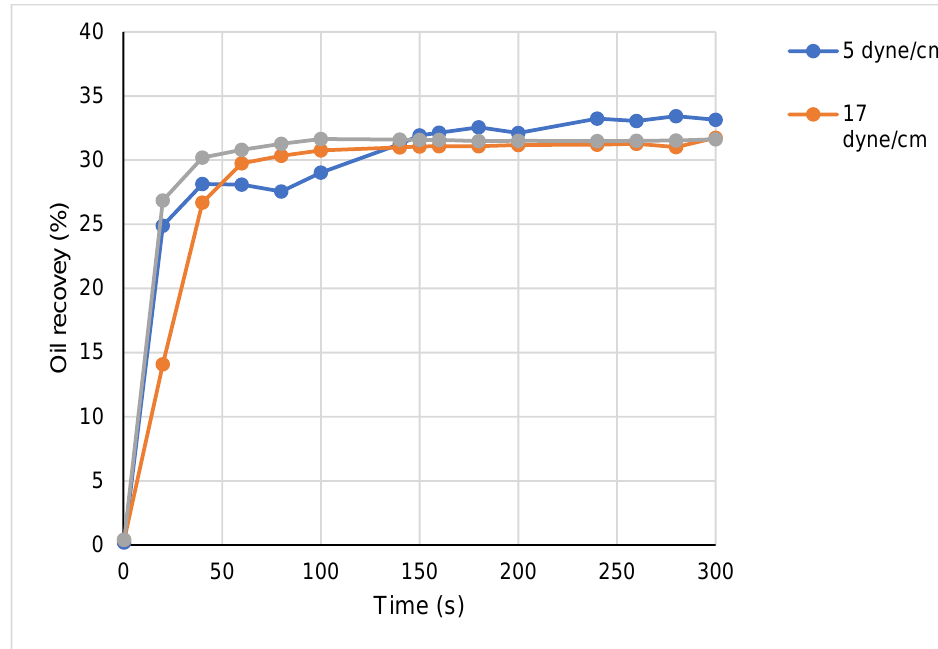
Figure 16. Effect of surface tension on oil recovery.